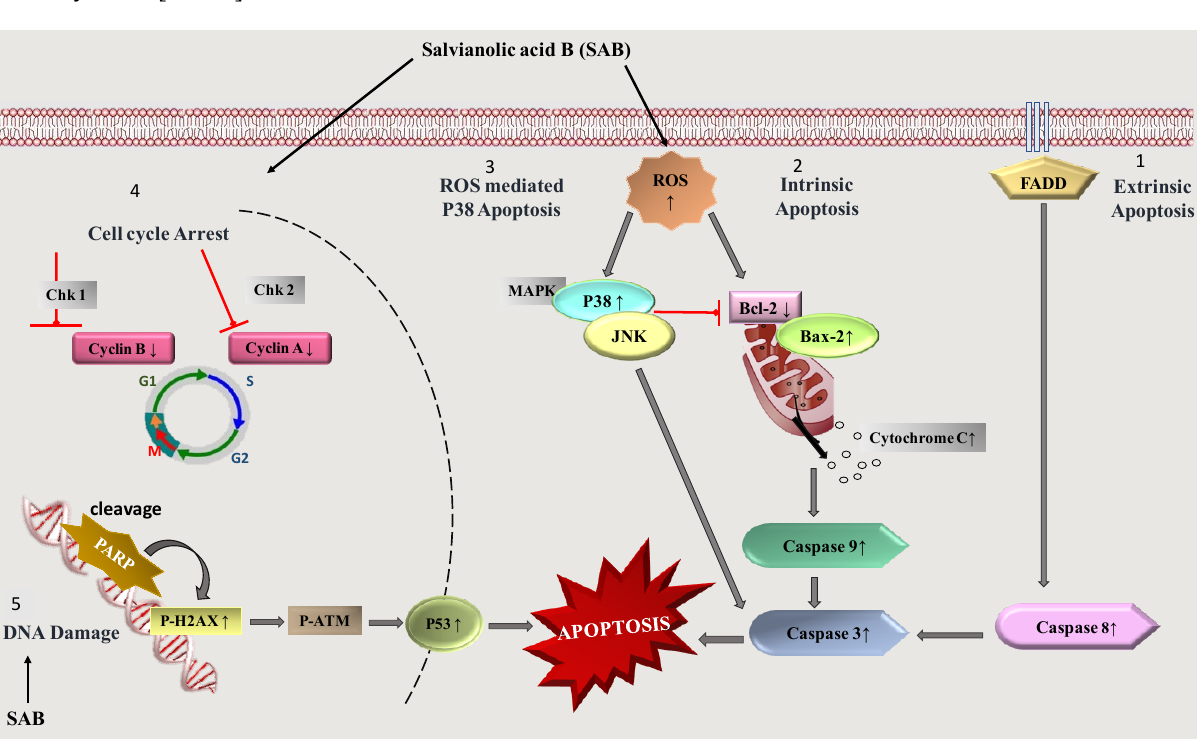
Figure 3. A diagram showing the induction of apoptosis and cell cycle arrest induced by SAB treatment. FADD: FAS-associated death domain protein; JNK: c-Jun N-terminal kinase; MAPK: mitogen-activated protein kinase; Chk: Checkpoints; ↑